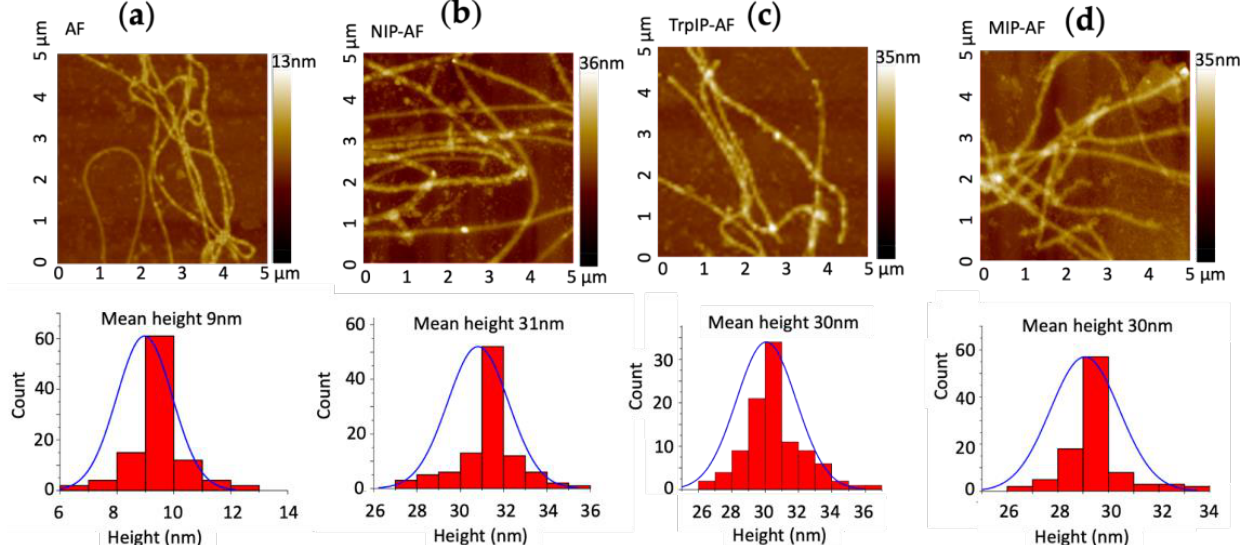
Figure 1. AFM topography images and height analysis; ( a ) AFM image and height analysis of amy- loid fibril; ( b ) AFM image and height analysis of NIP-AF; ( c ) AFM image and height analysis of TrpIP-AF; ( d ) AFM image and height analysis of MIP-AF.